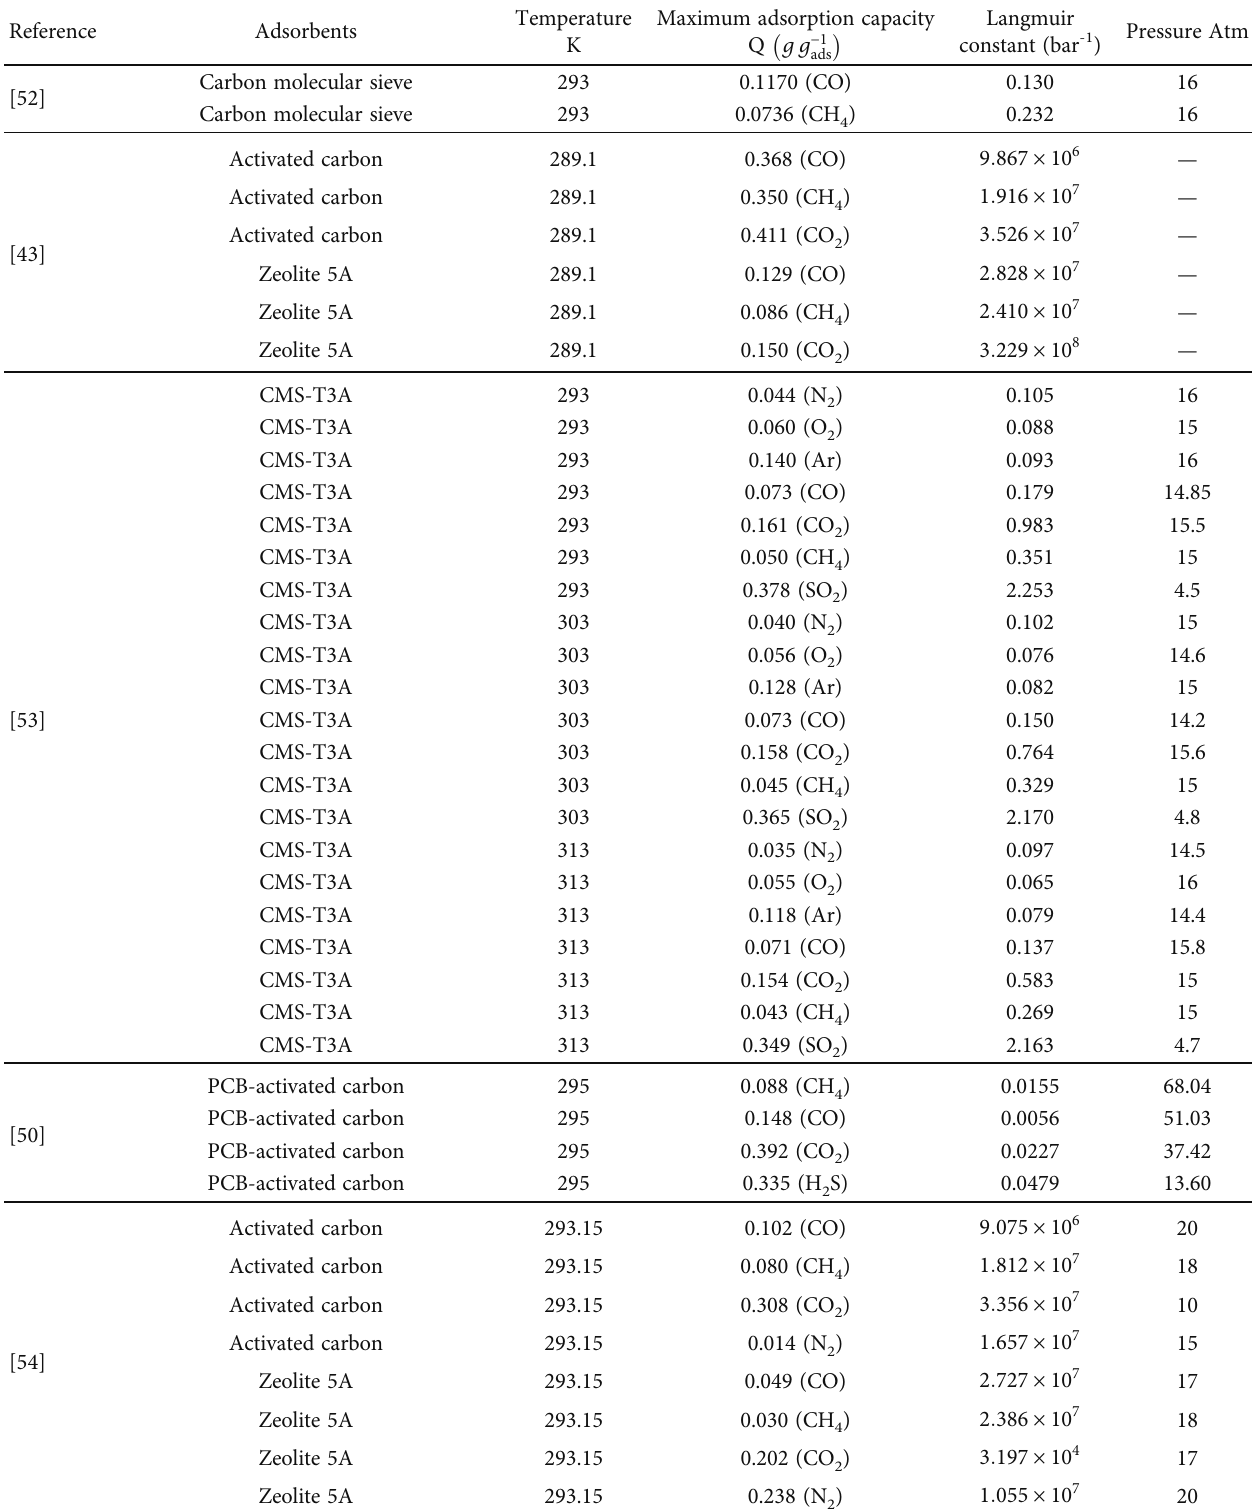
Table 8: Comparison of the thermodynamic values of various adsorbents as a function of di ff erent temperatures and pressures.